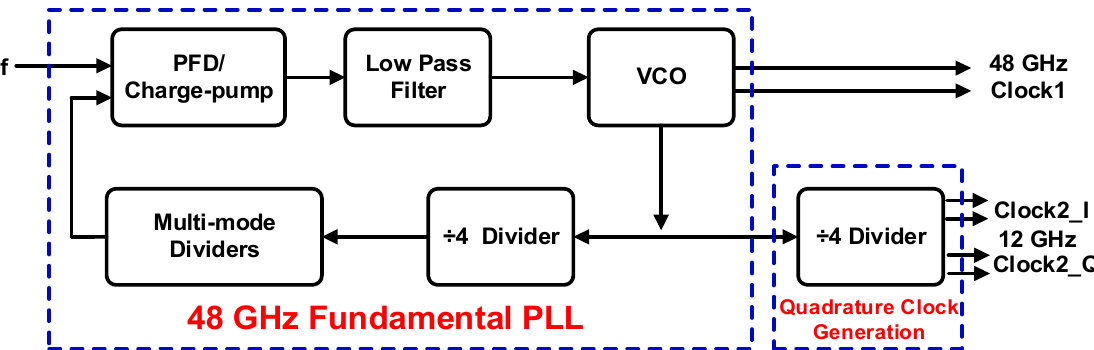
Figure 2. The proposed PLL and quadrature clock generation circuit.